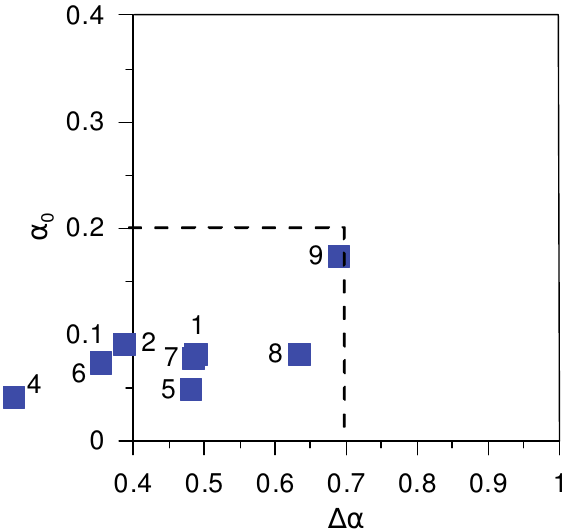
Fig. 8. Comparing an MF analysis of IMEP in the cylinders supplied by a mixture of non-modified composition of λ = 0.7 for 100 LL.